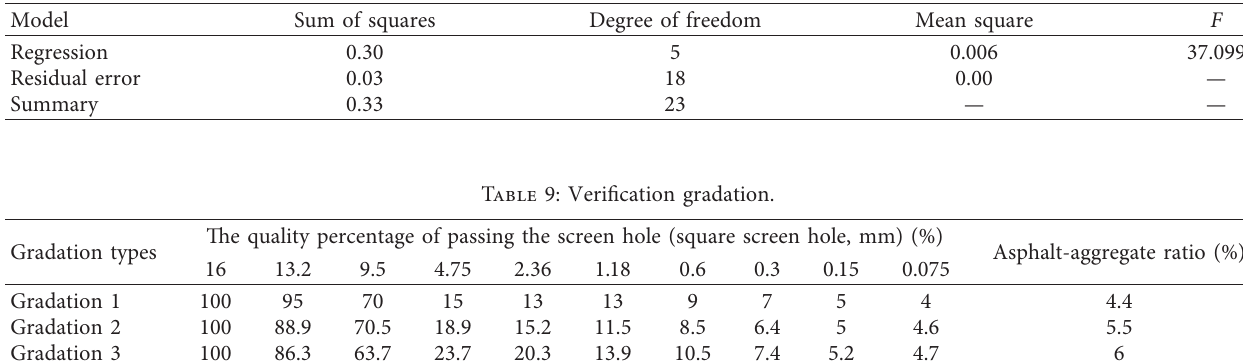
Table 8: Variance analysis.